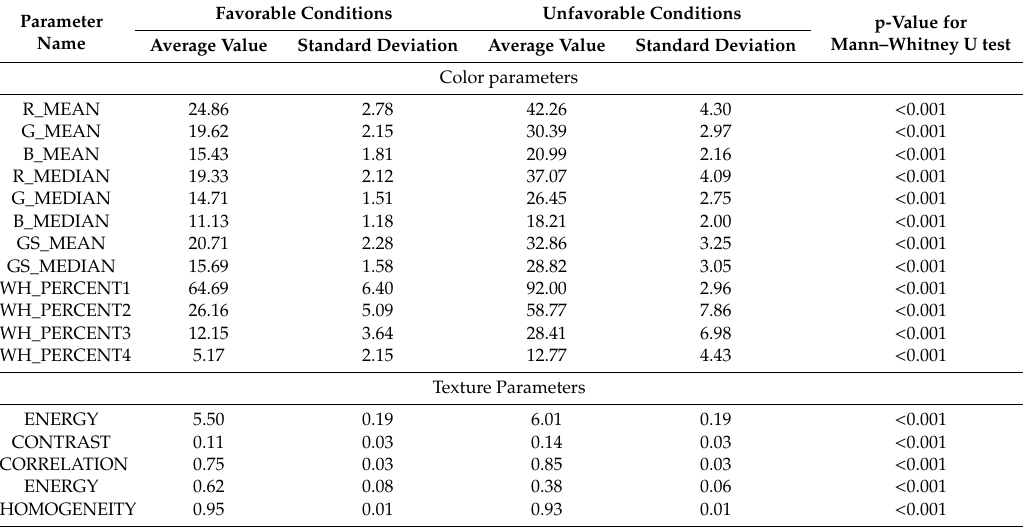
Table 3. Statistical information of the analyzed parameters of color and texture for the images of the material obtained under favorable and unfavorable composting